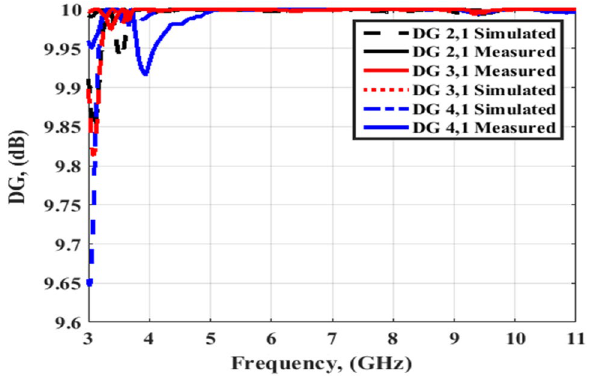
Figure 25. Port #1 DG simulated and testing outcomes of the flexible MIMO antenna in bending configuration with R = 45 mm.